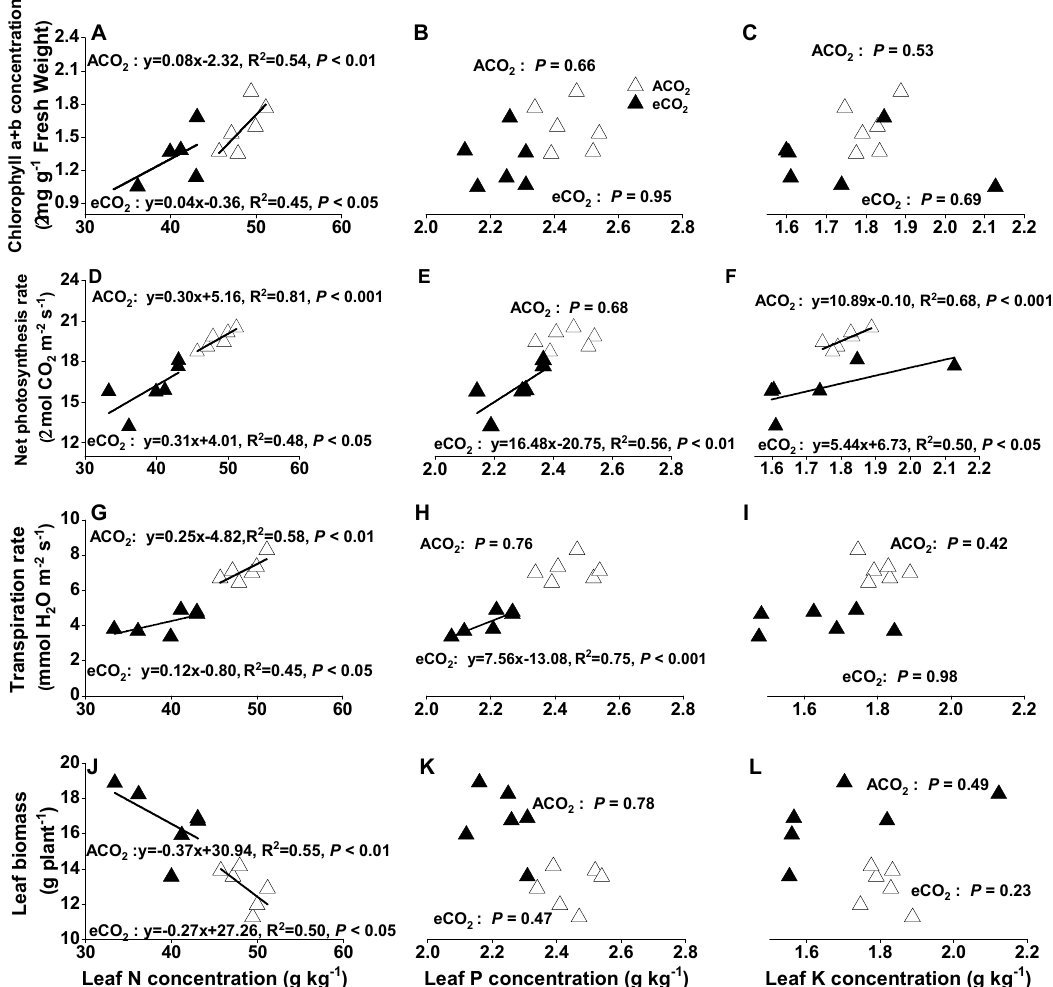
3.6. Relationships between Physiological Parameters and Tissue Nutrient Concentrations Chlorophyll a+b concentration, net photosynthetic rate and transpiration rate were significantly positively, while leaf biomass production was significantly negatively correlated to leaf N concentrations under both ACO 2 and eCO 2 (R 2 = 0.45–0.81, p < 0.05, Figure 6A,D,G,J).